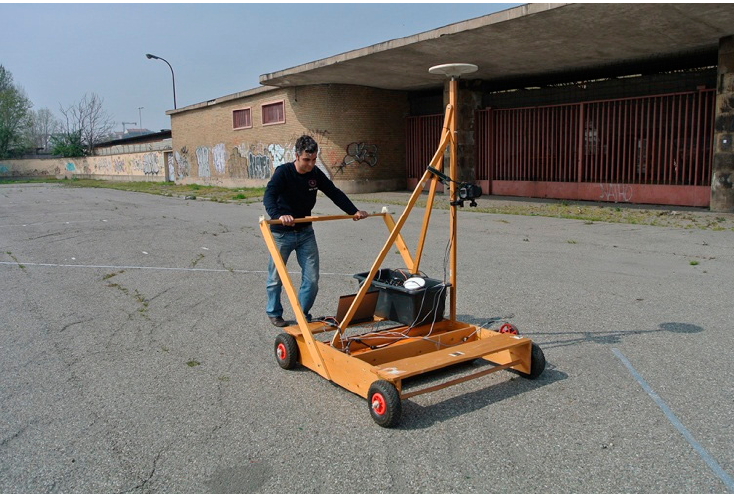
Figure 4. The system during the survey: the (orange) GPR is located at the bottom of the wood carrier, the GPS antenna is on the top of the stake, while the camera is fixed below it. The box in the lower part contains the other components of the system: the batteries and the hardware for controlling the camera. The laptop is near it. In the background it is possible to see the framed building. The façade is made of regular bricks, but some graffiti helps diversifying a bit the texture. This is not true for the gate. Note the different lighting conditions between the wall and the gate.